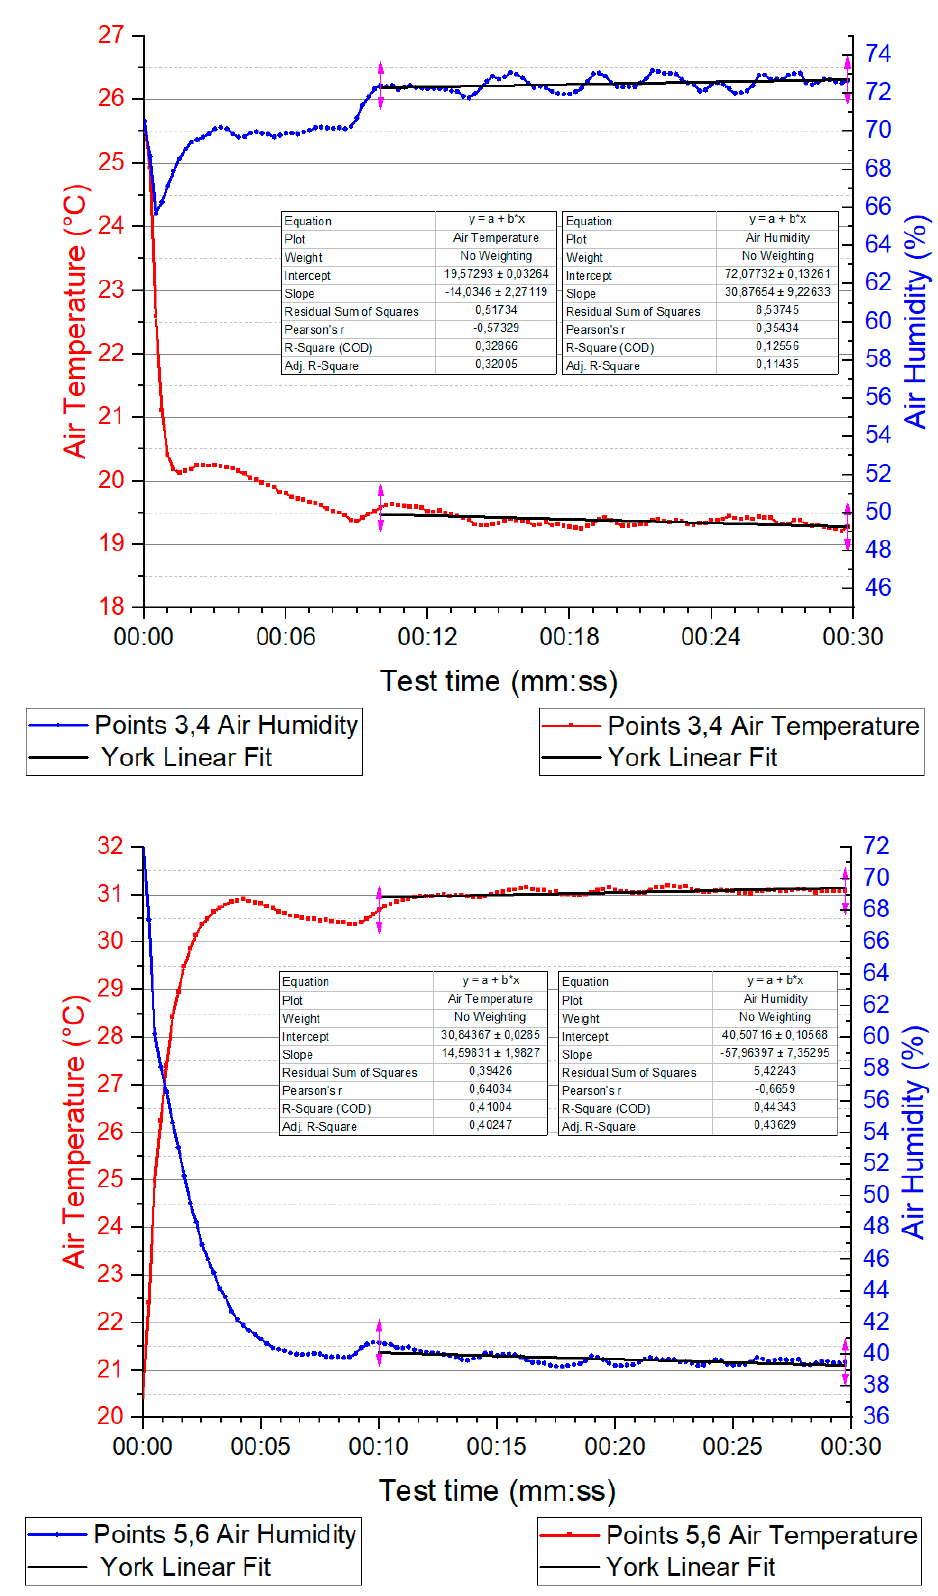
Figure 7. Distribution of air temperature and relative humidity at measuring points.